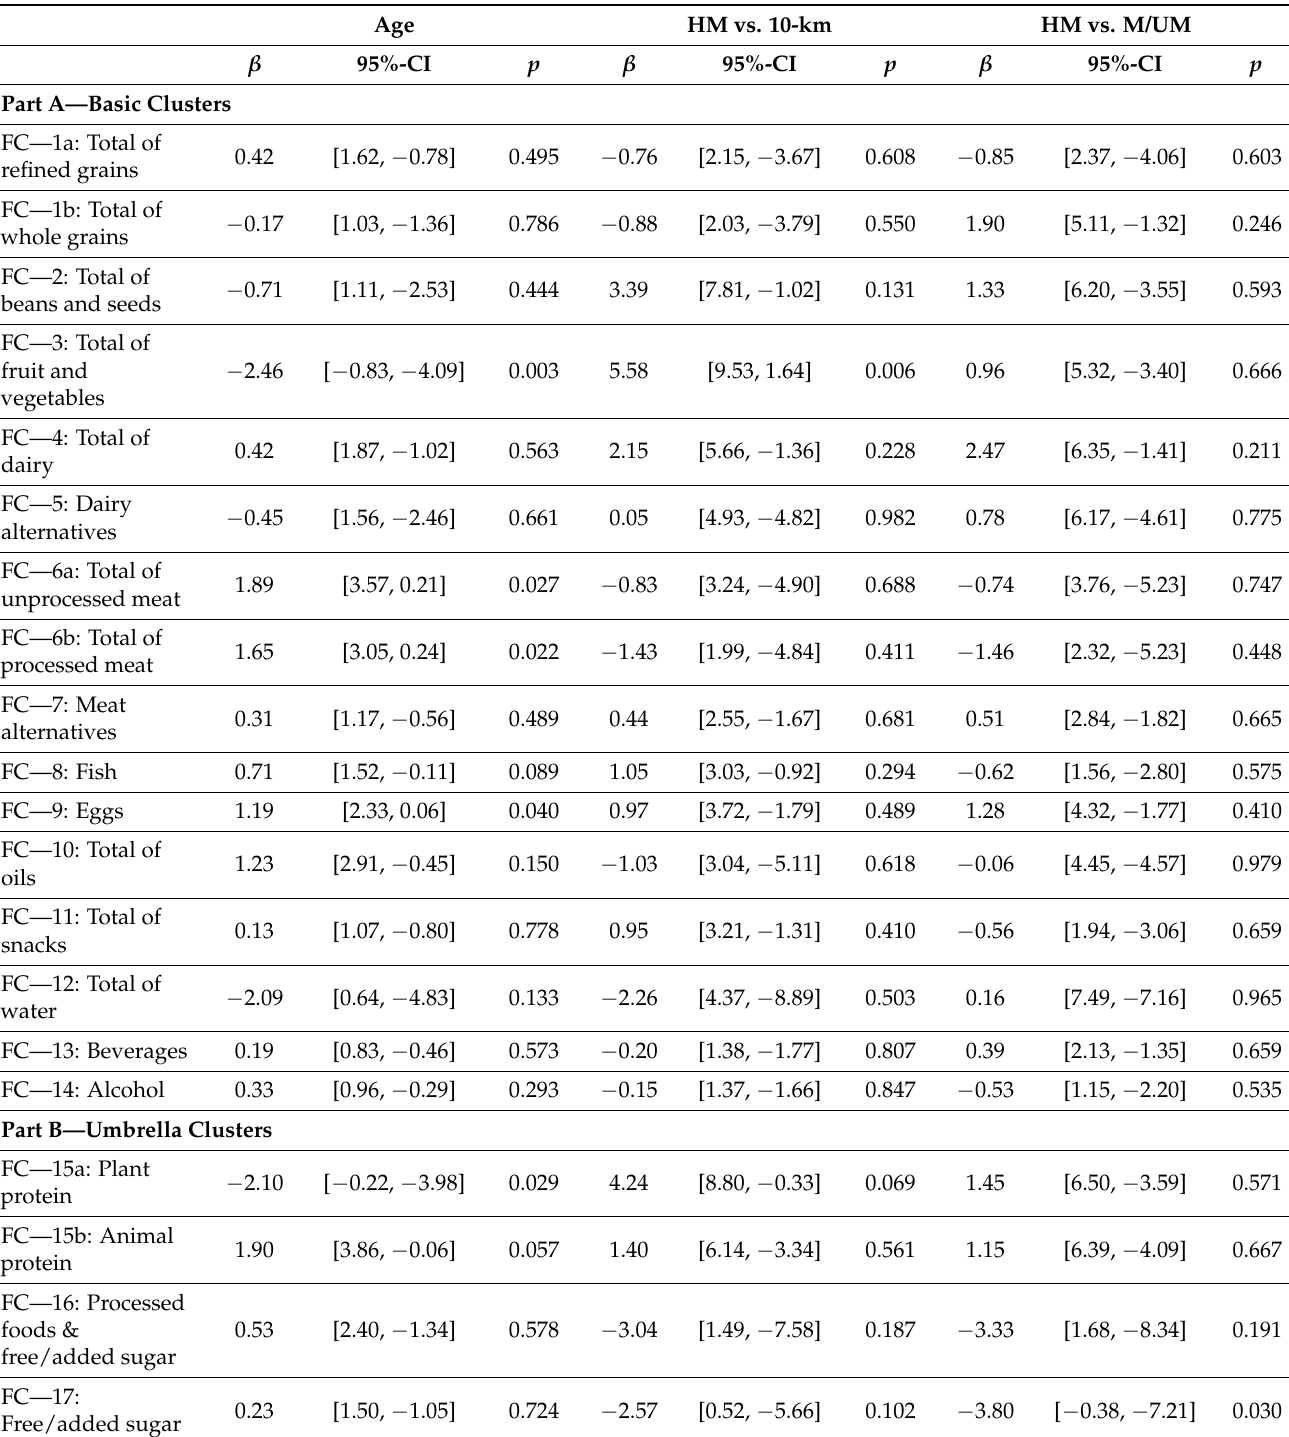
Table 4. Linear regression results for age- and race distance-related main effects on food clusters with HM runners as the reference group. Age HM vs. 10-km HM vs. M/UM